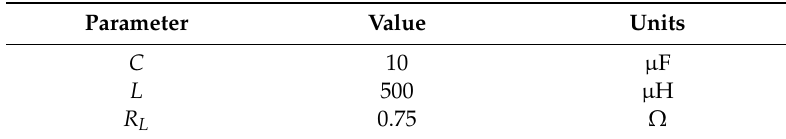
Table 3. Buck converter passive components.